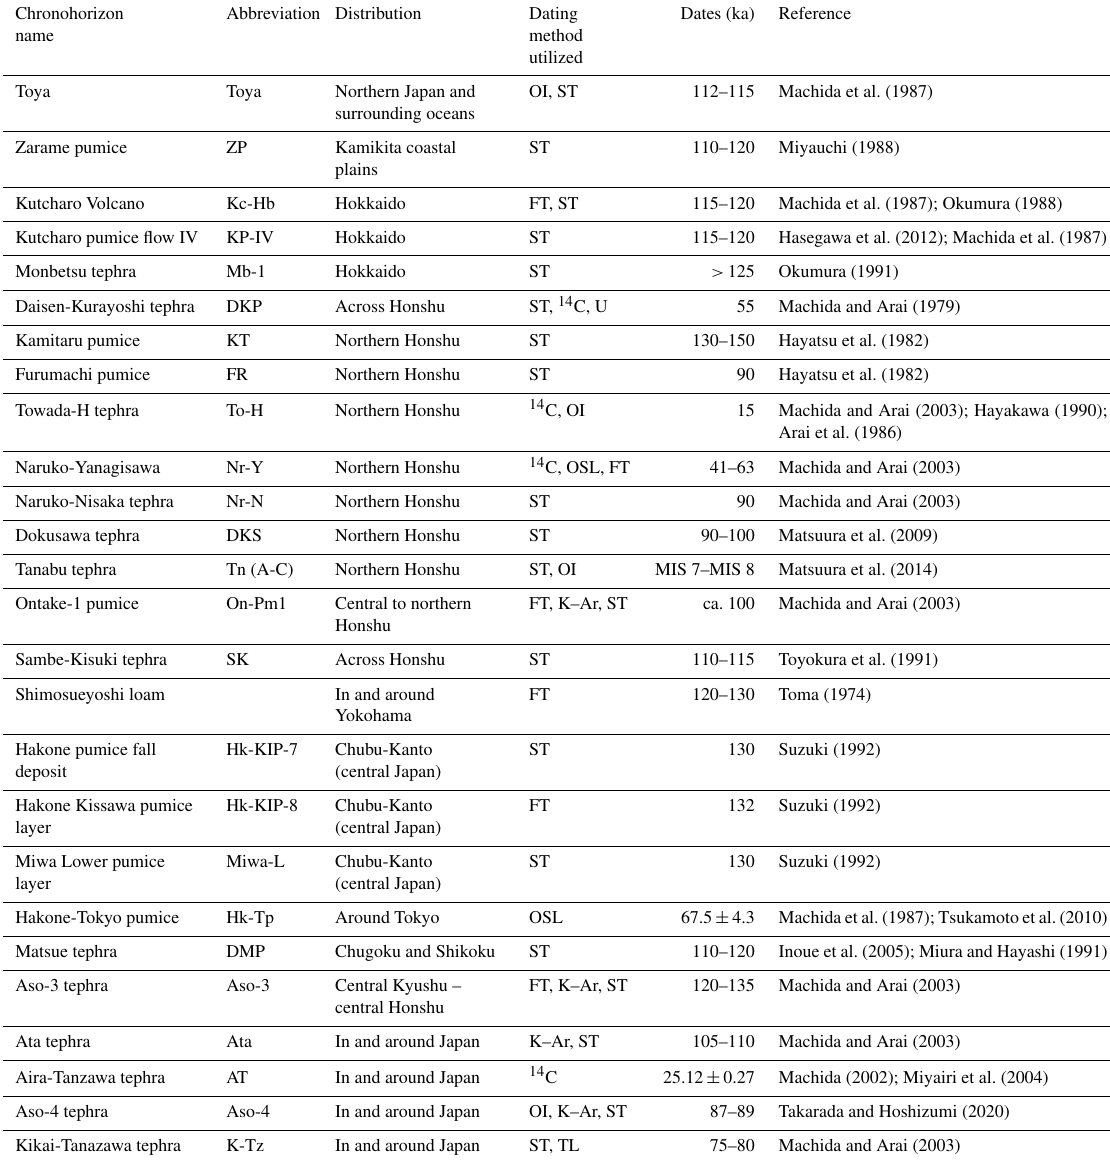
Table 4. A list of tephra chronohorizons utilized in the reviewed literature. Modified from Machida